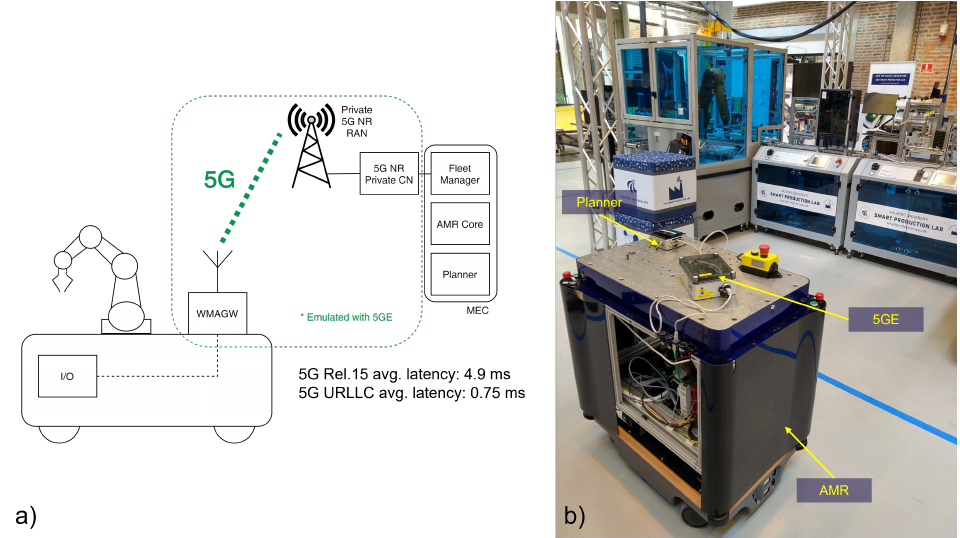
Figure 11. ( a ) Architecture of the 5G-integrated MEC AMR planner solution including the AMR, WMAGW, 5G network infrastructure, and AMR fleet manager controller and planner deployed in edge-cloud configuration. ( b ) Picture of the 5G-integrated MEC AMR planner solution deployed for 5G emulation at the